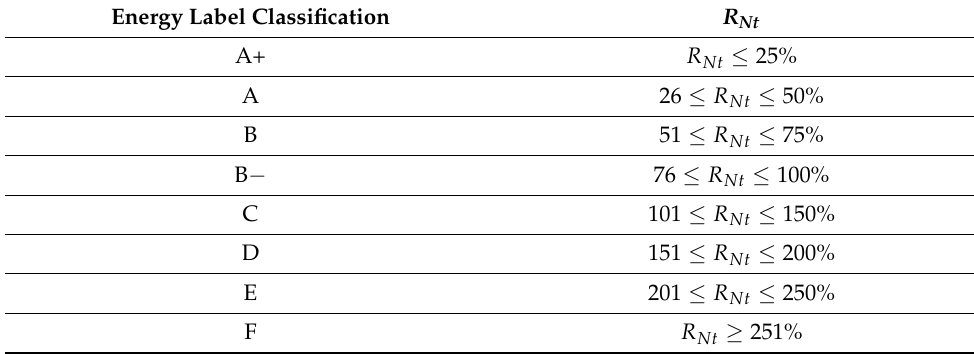
Table 2. Energy performance class for residential buildings according R Nt . Energy Label